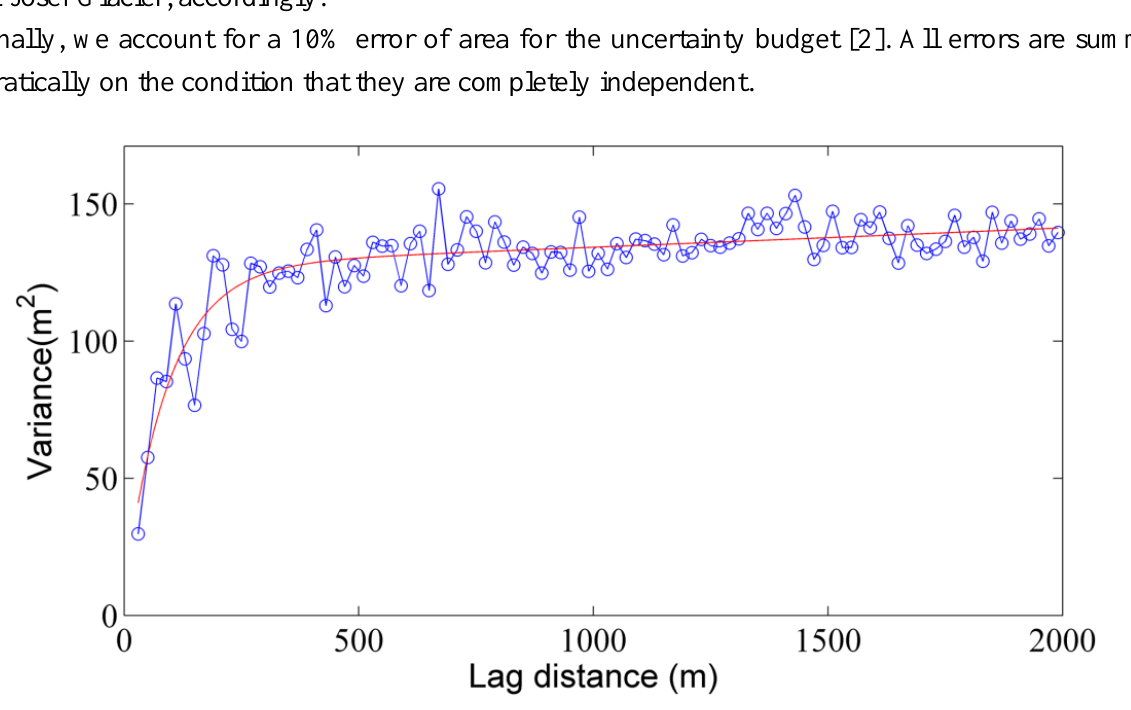
Figure 7. Semivariogram of elevation difference between ASTER DEM 2002/02/07 and the SRTM DEM, showing the decorrelation length (lag distance) from which the curve becomes “flattened”. An average decorrelation length of 400 m is estimated over all ASTER